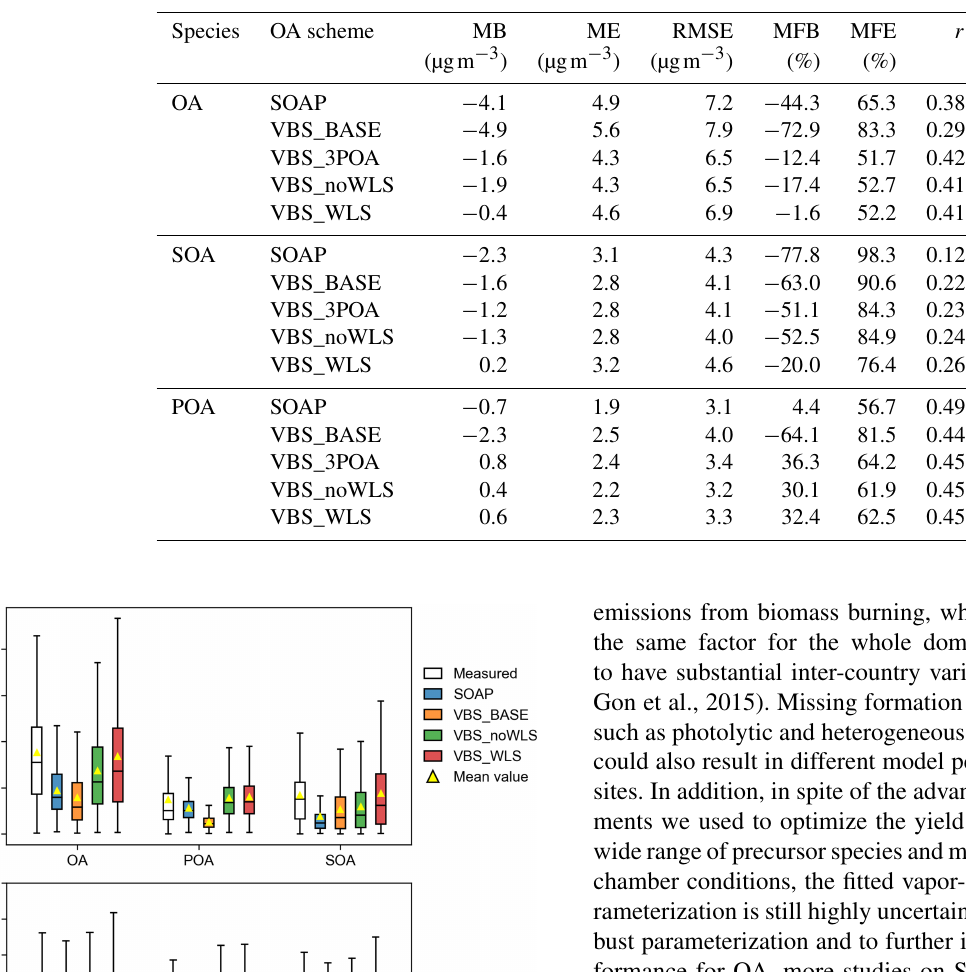
Table 2. Statistical results for model performance in simulating OA, SOA, and POA. The number of daily average observations from five ACSM/AMS stations is 216.